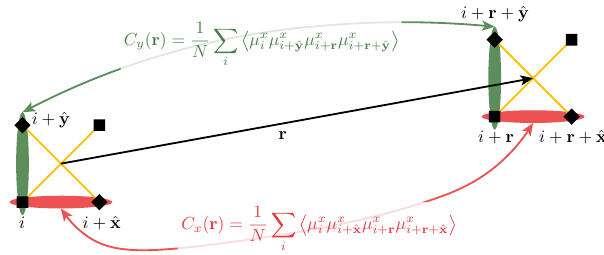
( r ) is taken between parallel pairs of neigh- Figure 12: The correlation function C a boring sites at a distance r . It can be either between horizontal pairs ( a = ˆ x , in red) or vertical pairs ( a = ˆ y , in